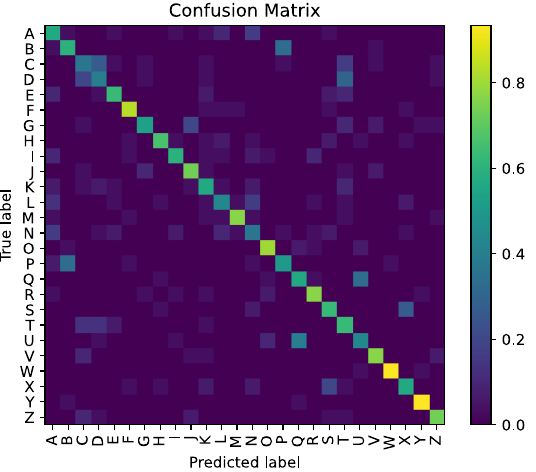
Figure 7. Confusion Matrix on the AVLetters Dataset.